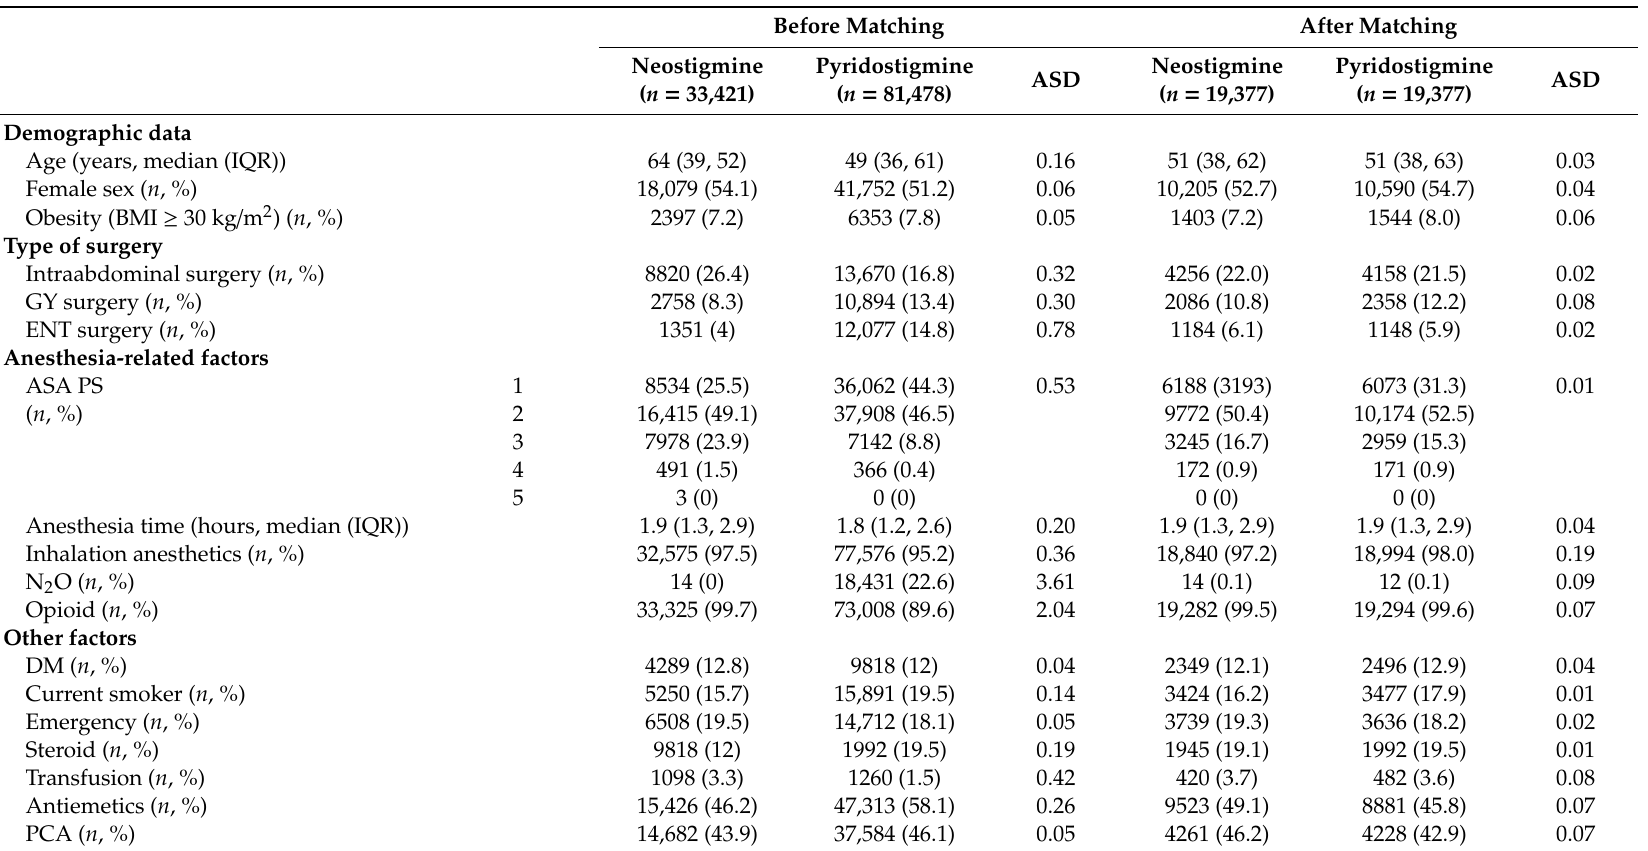
Table 3. Baseline patient characteristics and clinical data before and after matching: comparison between the neostigmine and pyridostigmine. Before Matching After